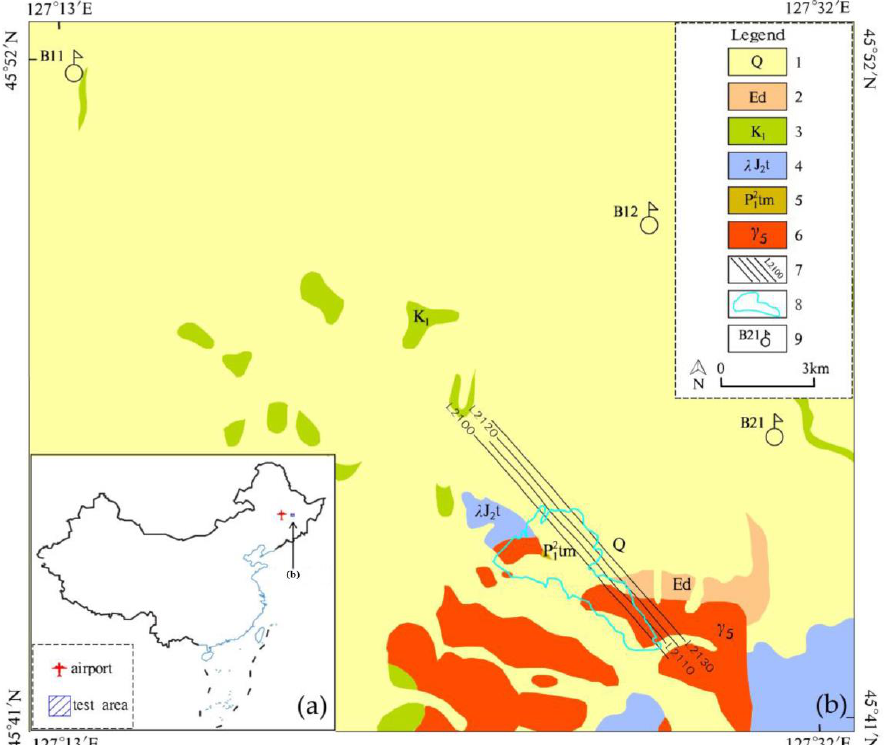
Figure 5. The overview ( a ) and zoom ( b ) of Binxian. 1—Quaternary clay and loam, 2—Paleogene sandy conglomerate and sandstone, 3—Cretaceous mudstone and sandstone, 4—Jurassic rhyolite and tuff, 5—Permian slate and sandstone, 6—Yanshanian granite, 7—flown footprint, 8—reservoir, 9—drills.